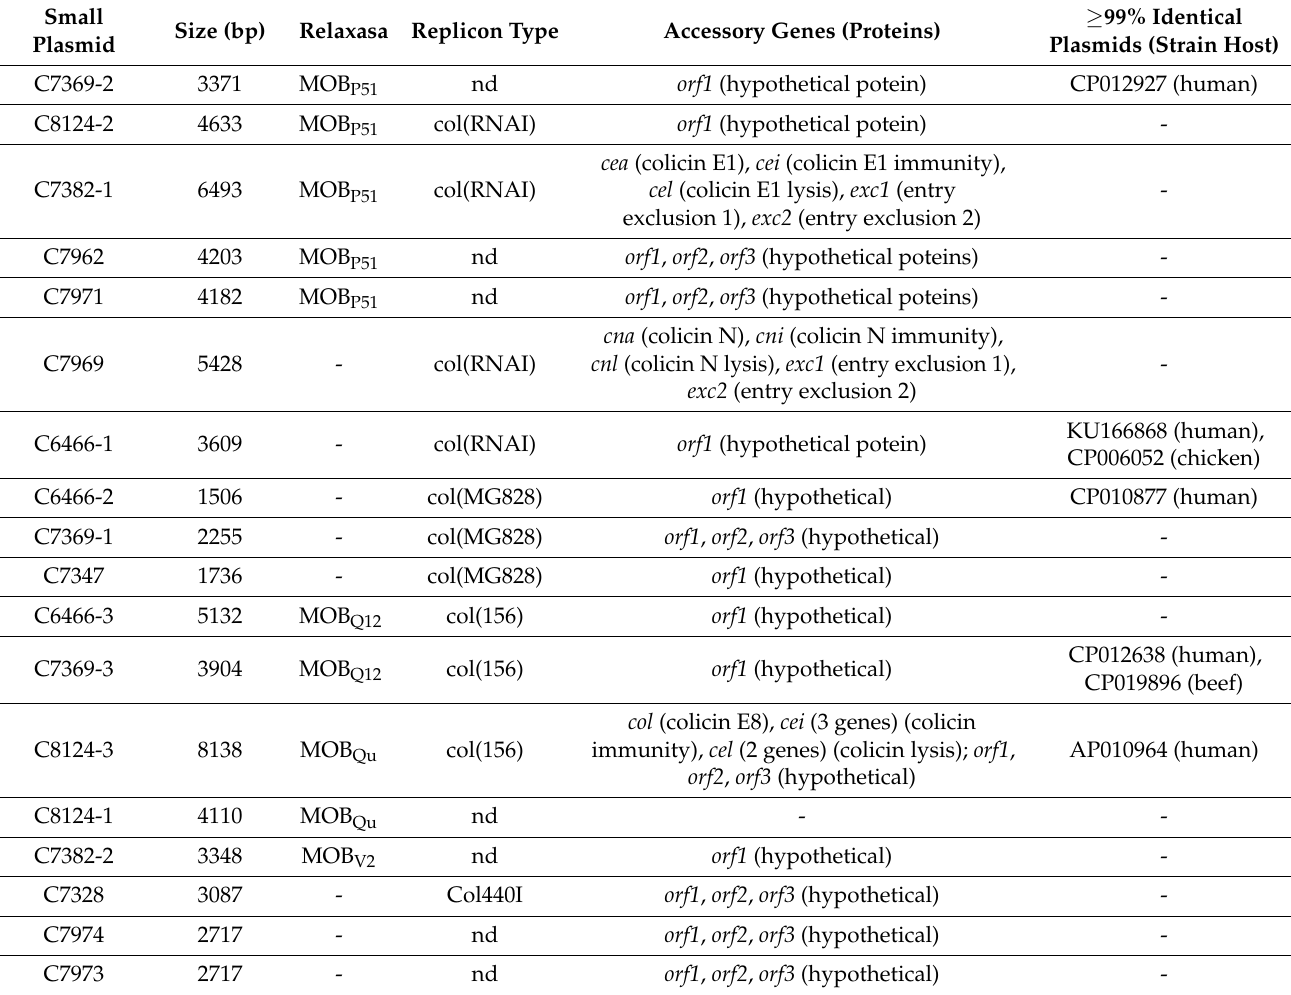
Table 1. Diversity and genetic features of small plasmids found among studied E. coli collection. Plasmids have been named according to the strain in which they are harbored (if ≥ 1 per isolate, they appear enumerated). Those replicons unable to be typed by using PlasmidFinder database are indicated as